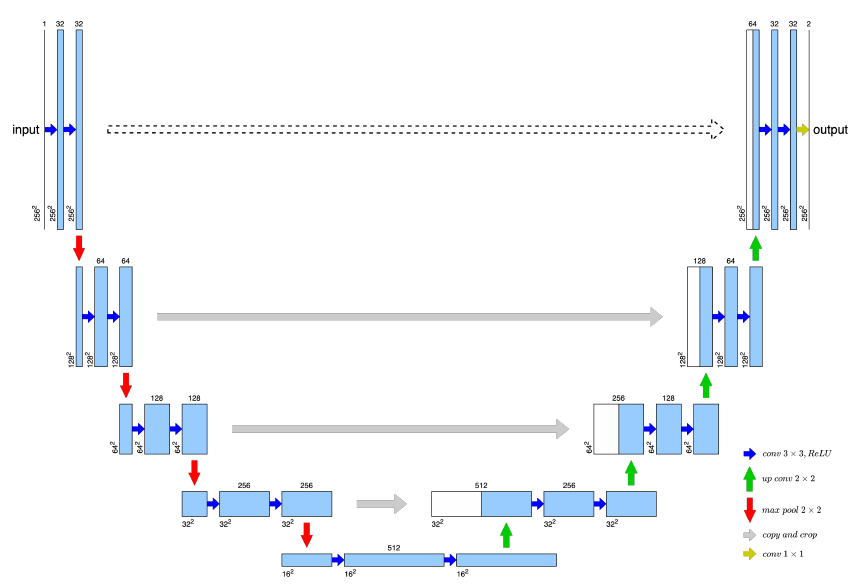
Figure 4. Architecture of the modified U-Net neuron network.